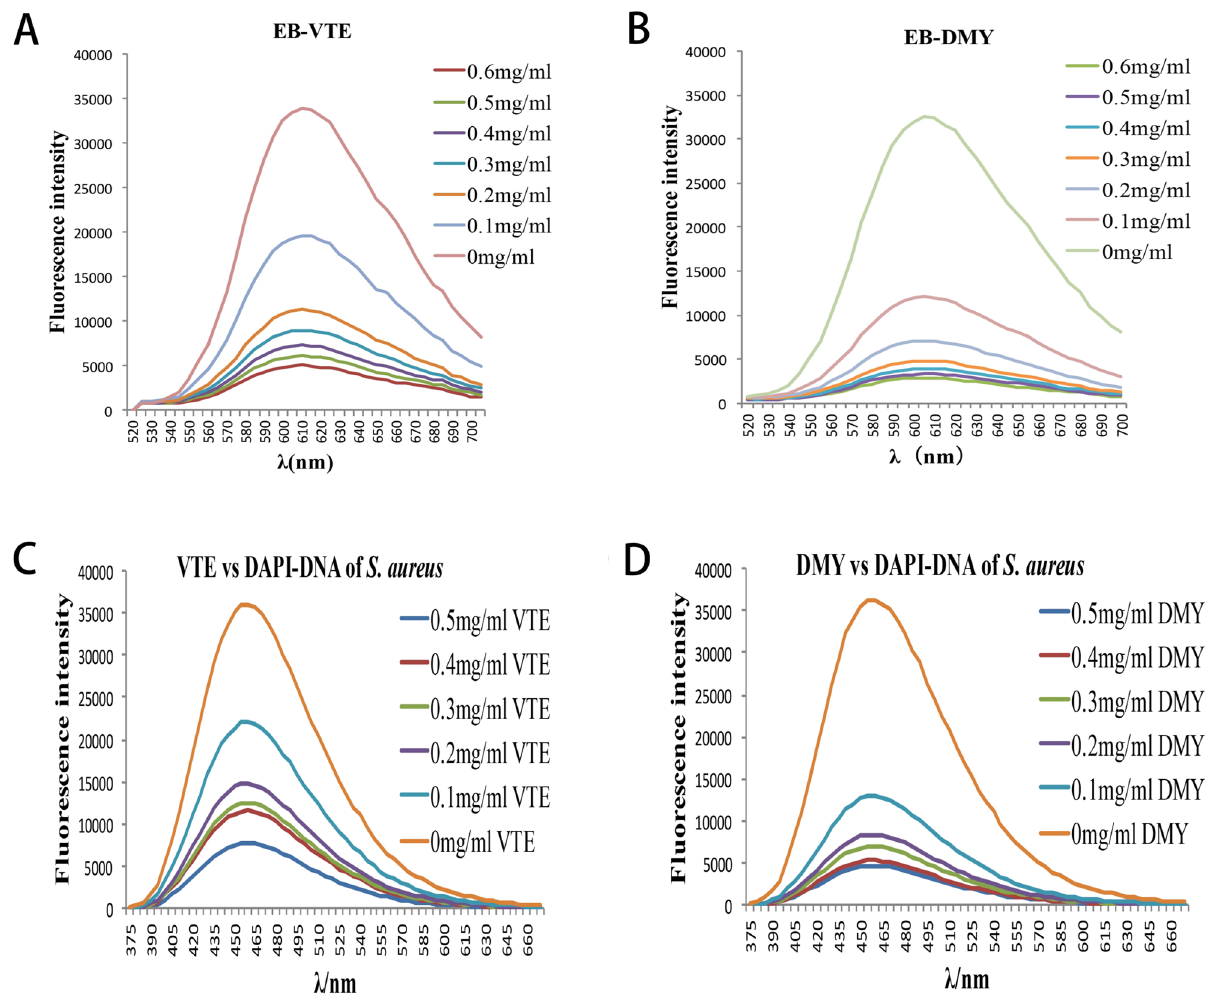
Figure 9. Effect of fluorescence intensity of VTE, DMY versus EB- S. Aureus genomic DNA system ( A , B ). Effect of fluorescence intensity of VTE, DMY versus DAPI- S. Aureus genomic DNA system ( C , D